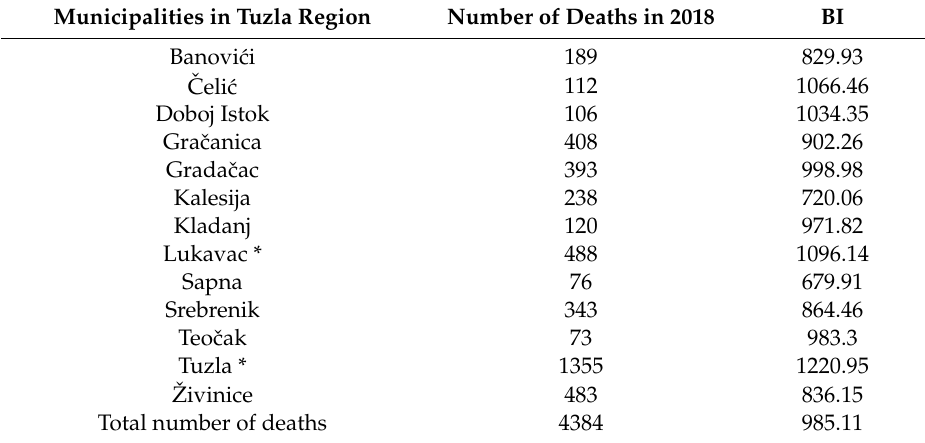
Table 2. Mortality cases and baseline incidence (BI) by all municipalities of the Tuzla region in 2018. Municipalities in Tuzla